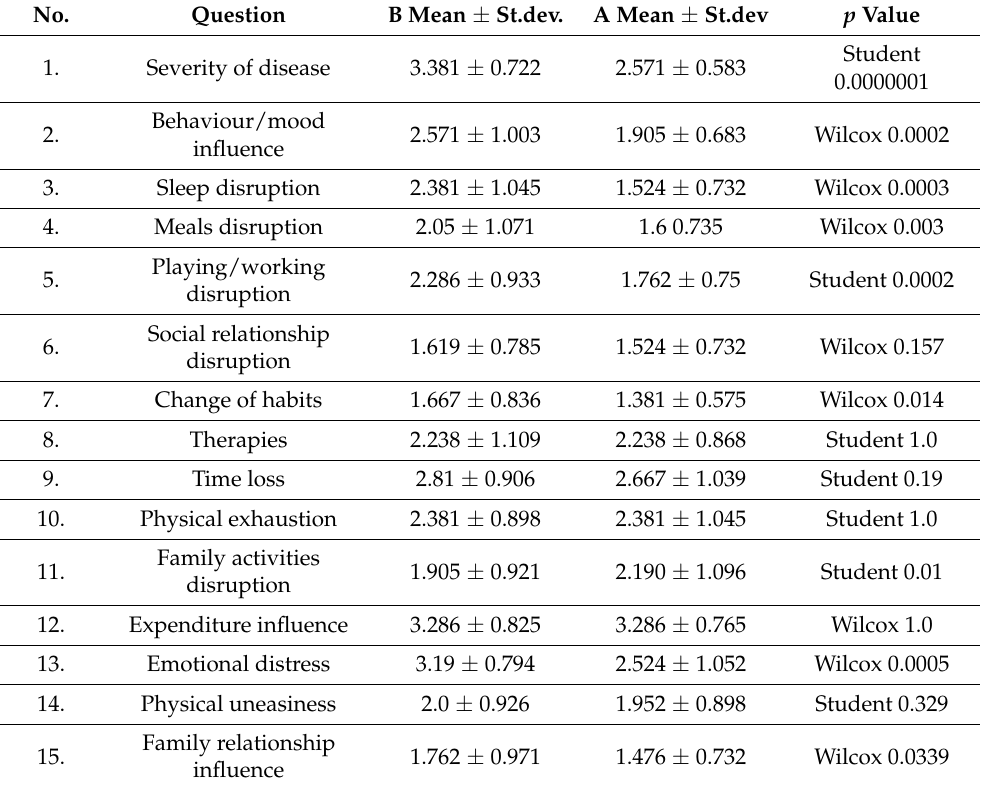
Table 1. Responses of the owners of dogs not treated with ASIT (control group; CG, No. = 21) before and after the